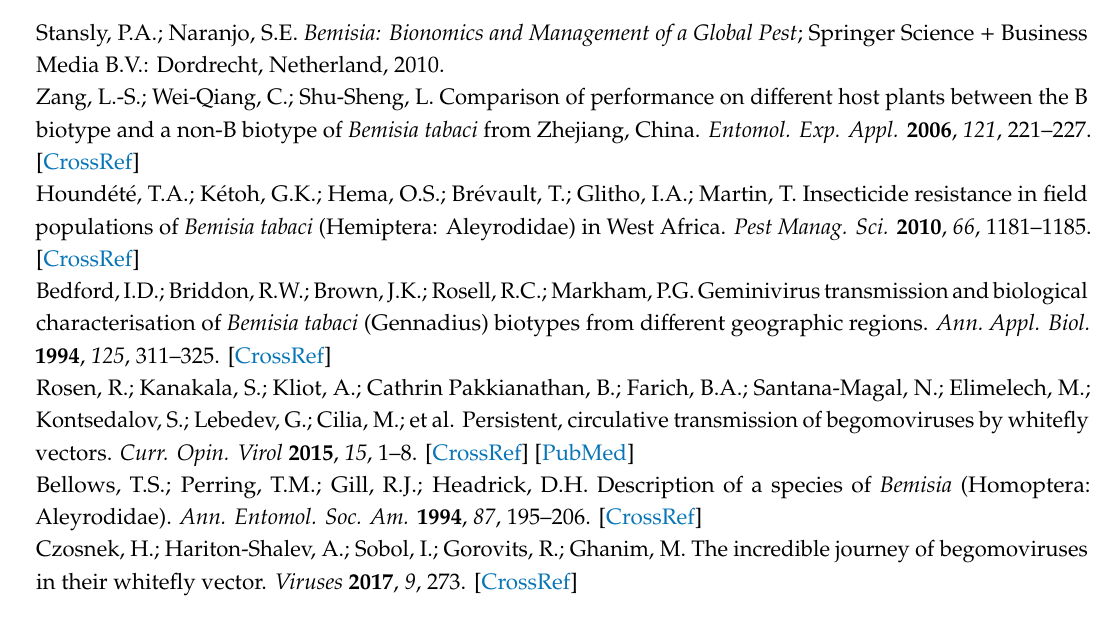
Figure S1: Predicted secondary structures for seven B. tabaci -specific miRNAs with various hairpins, Figure S2: RT-PCR validation of B. tabaci -specific and conserved miRNAs, Table S1: Summary of reads after trimming, filtering, and mapping to the whitefly genome, Table S2: Pearson’s correlation coe ffi cients for three biological replicates, Table S3: microRNAs found in B. tabaci MEAM1 and MED, Table S4: Novel miRNAs identified from this study with RPM > 10, Table S5: Primers used in this study, Table S6: All predicted targets for miRNAs identified in the current study, Table S7: Conserved miRNAs identified from this study with RPM > 10, Table S8: Fold change values for all 160 miRNAs and their predicted target genes in whiteflies fed on TYLCV-infected tomato, Table S9: Fold change values for miRNAs (fold change > 1.5 and RPM > 10) and their top five predicted target genes in whiteflies fed on TYLCV-infected